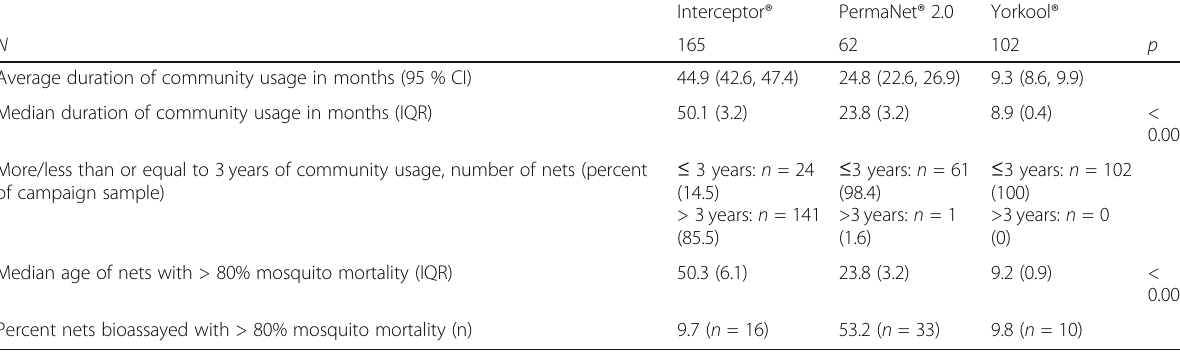
Table 2 Average duration of community usage and by effectiveness of LLIN brands